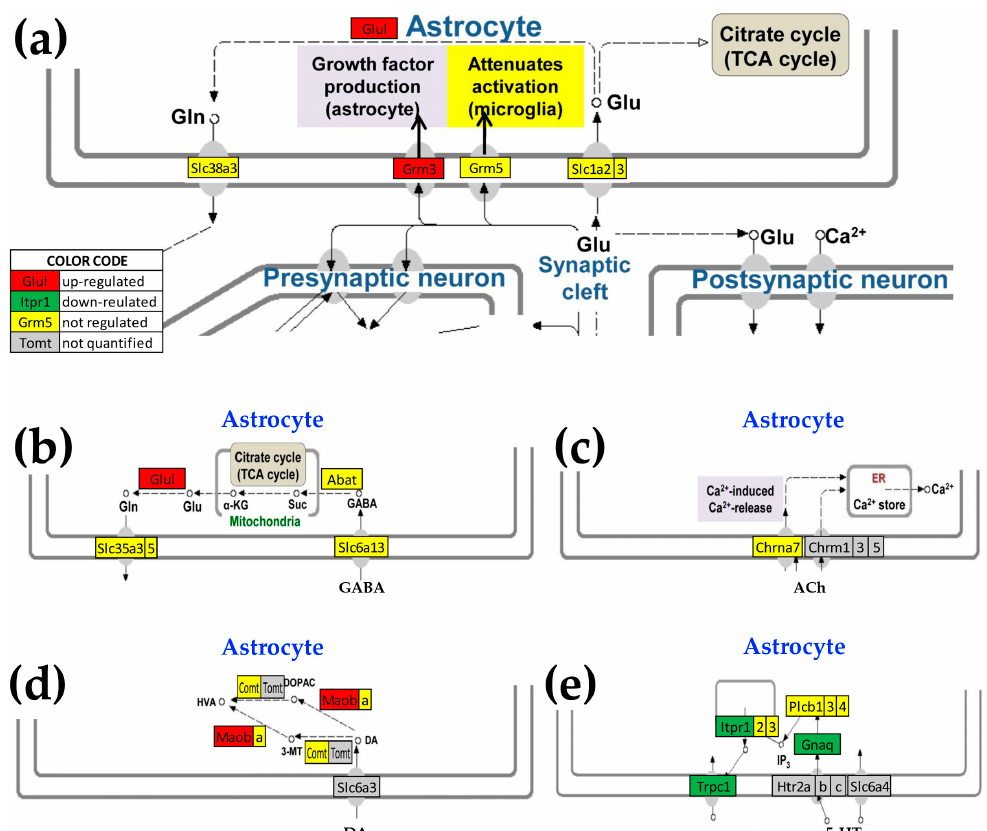
Figure 7. Astrocyte genes designated by KEGG pathways as corresponding to synaptic neurotransmission that were altered by the presence of Oli-neu cells ( a ) Astrocyte genes encoding proteins that interact with those in the pre- and post-synaptic. neuronal glutamatergic synapses (modified from mmu04724, kegg.jp), ( b ) astrocyte genes related to GABAergic synapses (modified from mmu04727, kegg.jp), ( c ) cholinergic synapse (modified from mmu04725, kegg.jp), ( d ) dopaminergic synapse (modified from mmu04728, kegg.jp), ( e ) serotonergic synapse (modified from mmu04726, kegg.jp). Genes: 4-aminobutyrate aminotransferase ( Abat ), cholinergic receptor, 487 nicotinic, alpha polypeptide 7 ( Chrna7 ), catechol-O-methyltransferase ( Comt ), glutamate-ammonia 488 ligase ( Glul ), guanine nucleotide-binding protein, alpha q polypeptide ( Gnaq ), metabotropic 489 glutamate receptors ( Grm3, Grm5 ), inositol 1,4,5-trisphosphate receptors ( Itpr1, Itpr2, Itpr3 ), 490 monoamine oxidases ( Maoa, Maob ), beta phospholipases C ( Plcb1, Plcb2, Plcb3 ), solute carriers ( Slc1a2, 491 Slc1a3, Slc35a3, Slc35a5, Slc38a3, Slc6a13 ), and transient receptor potential cation channel, subfamily 492 C, member 1 ( Trpc1 ). 493